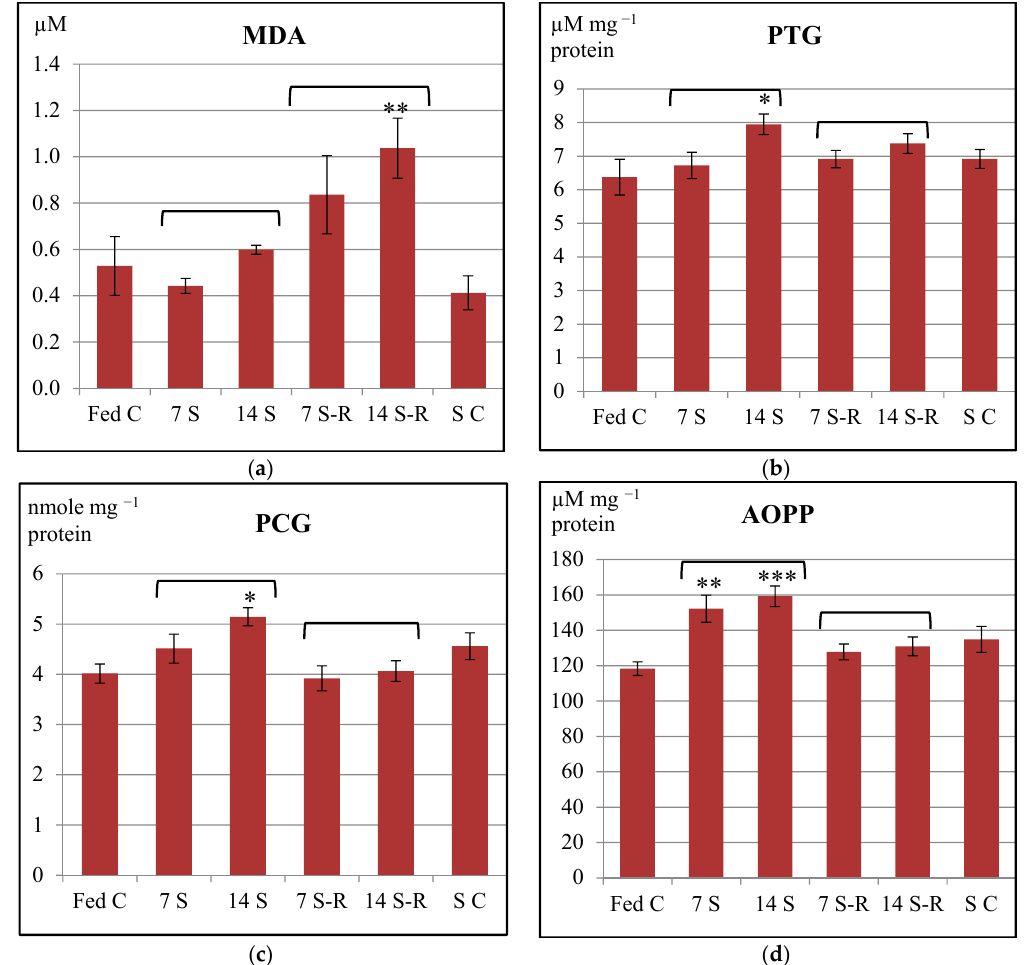
Figure 4. The level of oxidative stress biomarkers in the intestine of Acipenser stellatus juveniles subjected to different starvation/refeeding regimes. Lipid peroxidation biomarkers: ( a ) level of malondialdehyde (MDA). Protein oxidation biomarkers: ( b ) concentration of protein thiol groups (PTG). ( c ) The concentration of protein carbonyl groups (PCG). ( d ) The concentration of advanced oxidation protein products (AOPP). The data are illustrated as average value of the groups (n = 8) ± standard error of the mean (SEM). All data were statistically analyzed using one way—ANOVA. Statistical significance: * p < 0.05; ** p < 0.01; *** p < 0.001; the statistical significance of the changes is related to the fed control level and it is also presented between 7 S and 14 S groups and between 7 S-R and 14 S-R groups. Fed C—fed control group; 7 S—group starved for 7 days; 14 S—group starved for 14 days; 7 S-R—group starved for 7 days and refed 21 days; 14 S-R—group starved